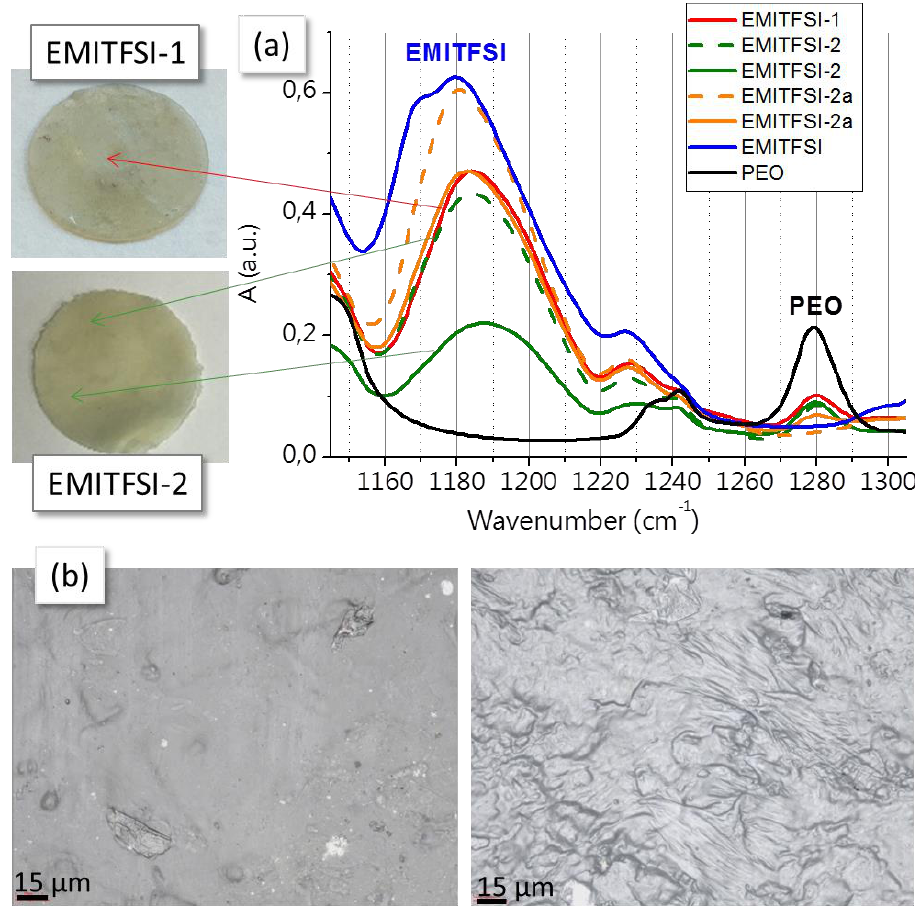
Figure 1. ( a ) Images of EMITFSI-1 and EMITFSI-2 and ATR–FTIR spectra performed at different points of the membranes for EMTFSI-1 (red), EMITFSI-2 (green), and EMITFSI-2a (orange). For EMITFSI-1, only one spectrum appears because there is no difference among them. ( b ) EMITFSI-2 profilometry 2D images 50x magnification, polymer-poor phase (left) and polymer-rich phase (right). The field size in both images is 265 × 199 μm.